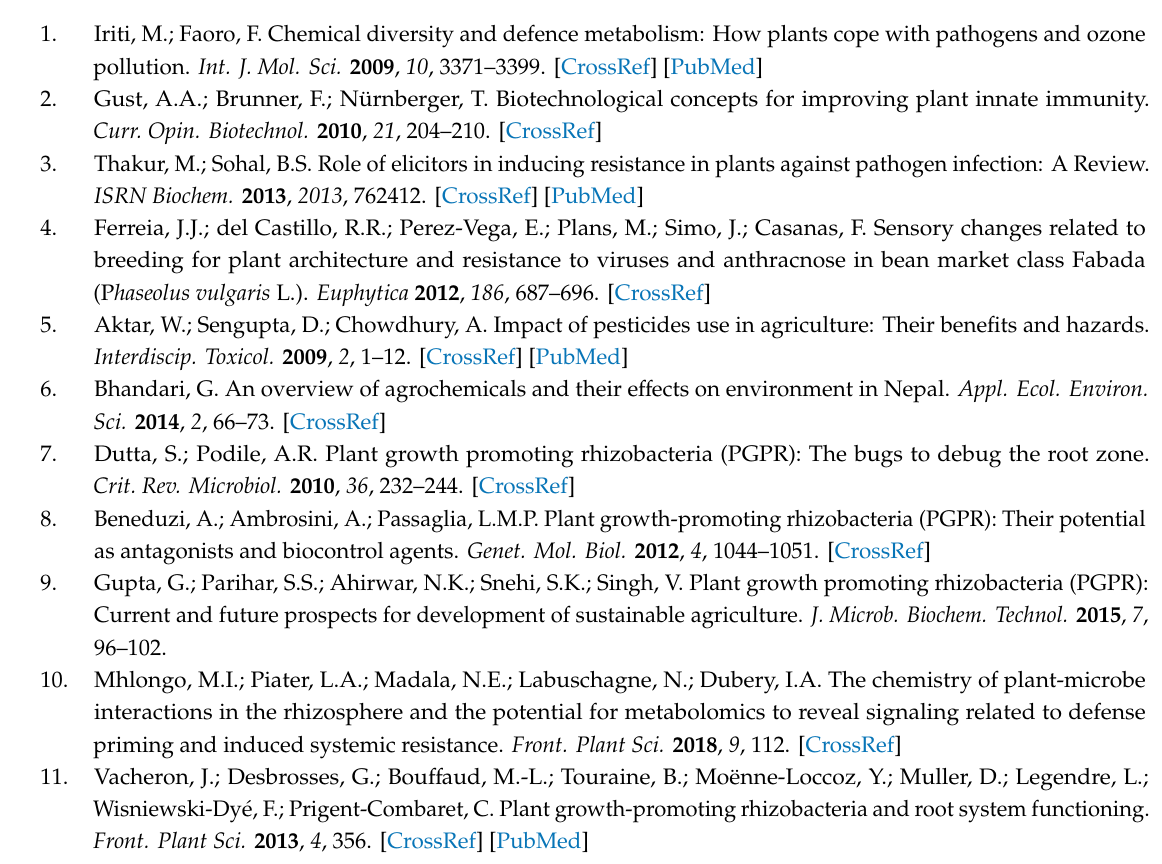
Figure S19: Identification of discriminatory biomarkers of Lysinibacillus sphaericus T19-treated stem samples using OPLS-DA modeling.; Figure S20: Identification of discriminatory biomarkers of Paenibacillus alvei T22-treated stem samples using OPLS-DA modeling.; Figure S21: Identification of discriminatory biomarkers of Pseudomonas fluorescens N04-treated root samples using OPLS-DA modeling.; Figure S22: Identification of discriminatory biomarkers of Pseudomonas koreensis N19-treated root samples using OPLS-DA modeling.; Figure S23: Identification of discriminatory biomarkers of Lysinibacillus sphaericus T19-treated root samples using OPLS-DA modeling.; Figure S24: Identification of discriminatory biomarkers of Paenibacillus alvei T22-treated root samples using OPLS-DA modeling.; Figure S25: Schematic overview of branch pathways of the phenylpropanoid pathway leading to the synthesis of benzoic acids, hydroxycinnamic acid derivatives and flavonoids.; Table S1: Annotation of individual aromatic amino acids by retention time, m / z values and identification by MS / MS fragmentation patterns.; Table S2: Parameters of the calibration curve for each aromatic amino acid including curve range, correlation coe ffi cient, limit of detection (LOD) and limit of quantification (LOQ)., Table S3: One-way ANOVA comparing mean values of quantified aromatic amino acids (Phe, Tyr and Trp) is roots, stems and leaves of PGPR inoculated plants.; Table S4: Post-hoc statistical tests comparing mean values of the distribution of the aromatic amino acids (Phe, Tyr and Trp) is roots, stems. and leaves of PGPR inoculated